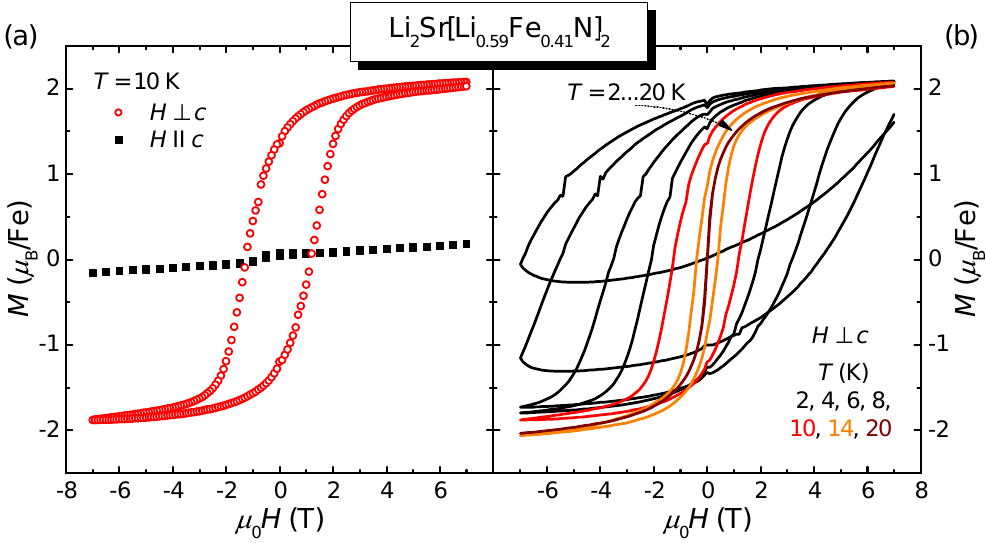
Figure 5. Isothermal magnetization in µ B per Fe at T = 10K; ( a ) Large hysteresis emerges for field applied perpendicular to the c -axis (which is perpendicular to the N–Fe–N ’molecular axis’); ( b ) The hysteresis for H ⊥ c increases rapidly with decreasing temperature. Spontaneous magnetization disappears for temperatures larger than T ∼